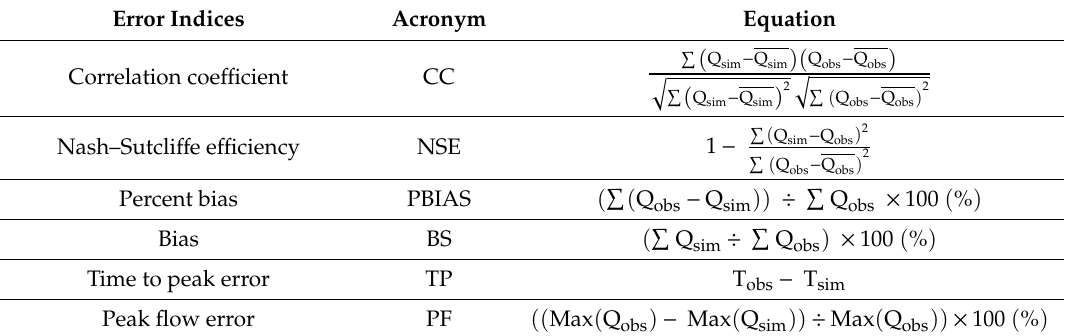
Figure 4. Box–whisker plots of error indices for evaluation of the NWM performance. The hourly streamflow data (15–18 February 2004) and five indices (correlation coefficient (CC), Nash–Sutcliffe efficiency (NSE), percent bias (PBIAS), peak flow (PF) (%), and time to peak (TP) (h)) were used for evaluation. These plots show the distribution of the values of error of simulated streamflow data. The red spotted line means the ideal value of each index (e.g., simulated value is perfectly fit to the observation). Table 3. Statistics for evaluation of NWM simulation